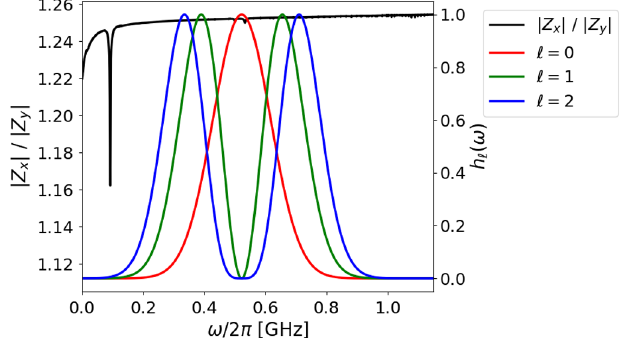
FIG. 2. Ratio of the horizontal to vertical impedances (black) of the LHC at 6.5 TeV plotted alongside the first three bunch modes (red, green and blue).